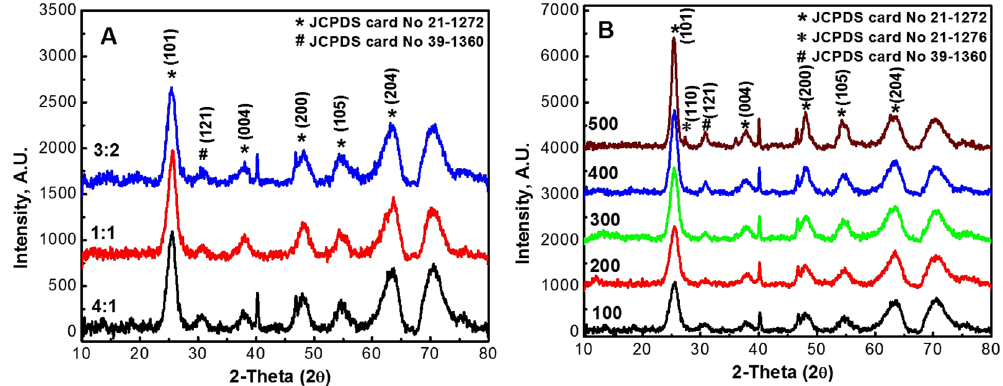
Figure 1. XRD patterns of TiO 2 NPs at different ( A ) ethanol: water ratios (at 100 °C) and ( B ) temperatures (ratio 4:1 v/v